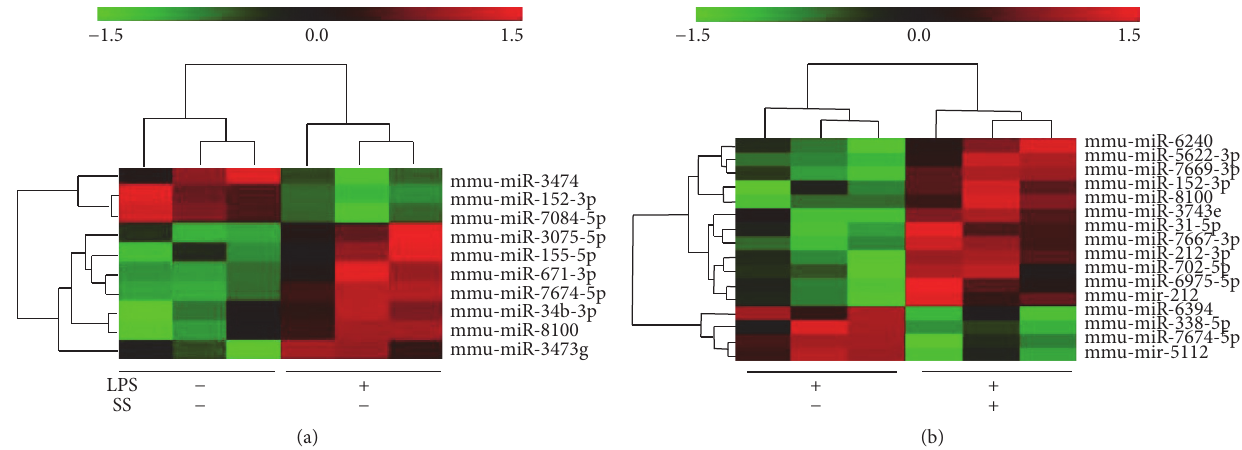
Figure 4: miRNA profiles in Kupffer cells under different conditions. (a) Comparison of observed miRNAs in normal Kupffer cells and LPS stressed Kupffer cells. (b) Comparison of observed miRNAs in LPS stressed (untreated) Kupffer cells and 10% SNN-containing serum treated cells. The columns and rows represent samples and particular miRNAs. Experiments were repeated three times for each group; SS: SNN-containing